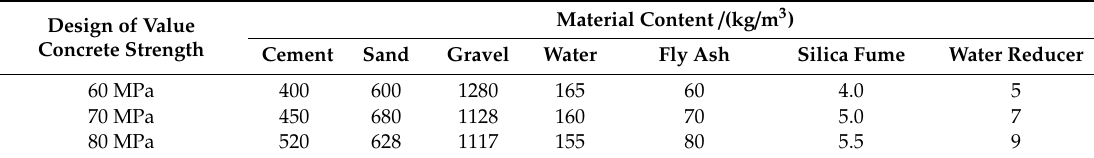
Table 2. Concrete proportions.